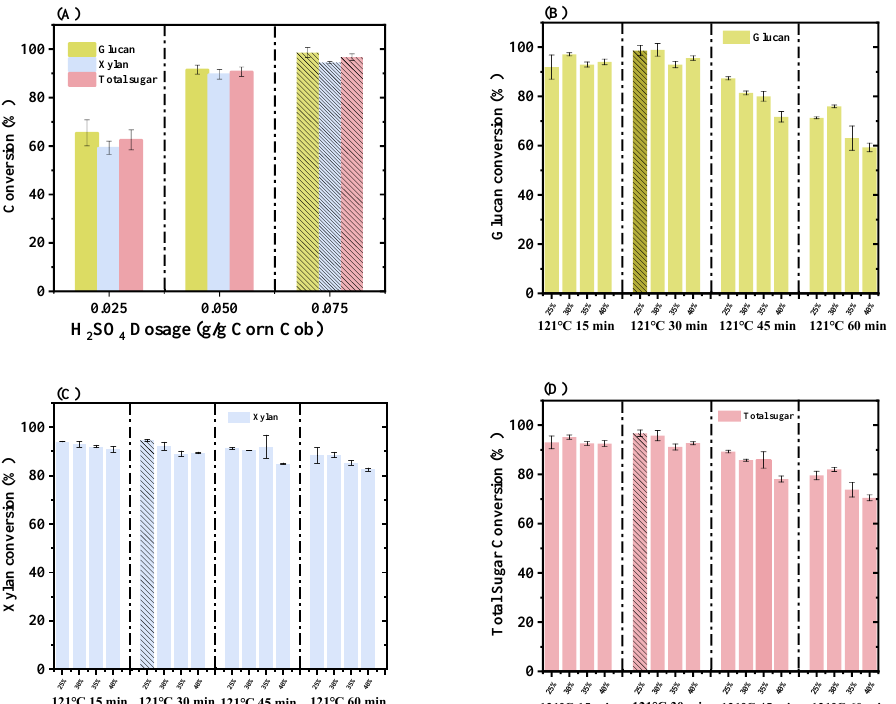
Figure 1. Effects of sulfuric acid dosage ( A ), autoclave time and solid loading ( B – D ) on DLCA pretreatment of corncob. Enzymatic hydrolysis on pretreated corncob at 3% ( w / w ) solid loading was performed for 24 h at 50 °C with enzyme dosage of 15 mg protein/g glucan to evaluate the sugar conversions for pretreated corncob. The effect of different sulfuric acid dosages was investigated after autoclaving for 30 min at 25% solid loading. DLCA: Densifying lignocellulosic biomass with sulfuric acid followed by autoclave.